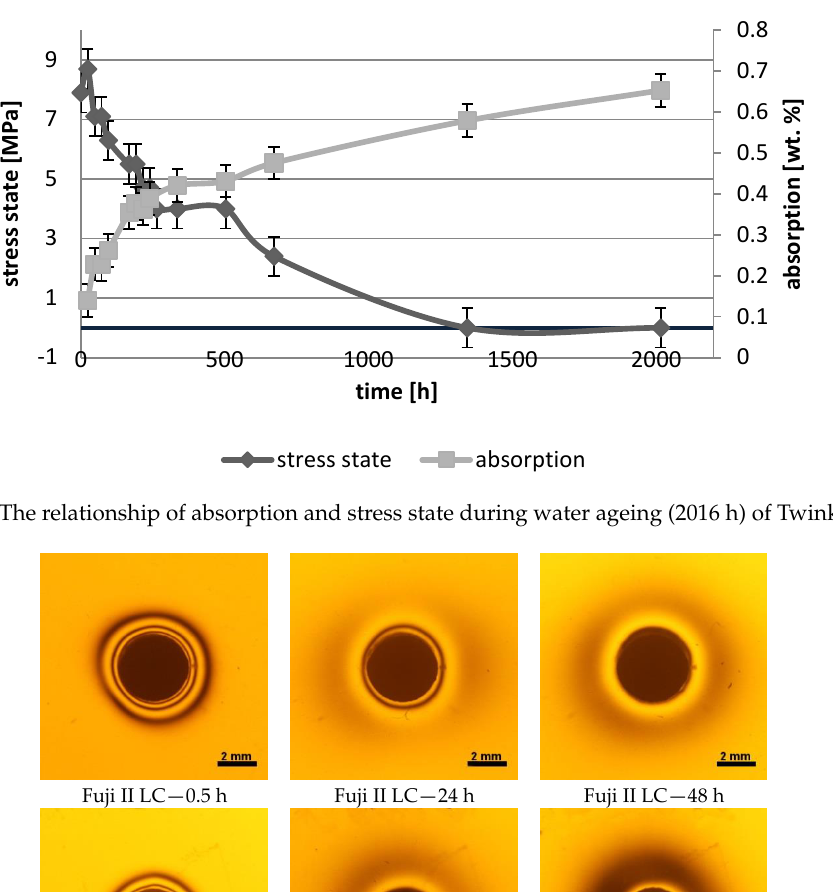
Figure 7. The relationship of absorption and stress state during water ageing (2016 h) of Glasiosite.